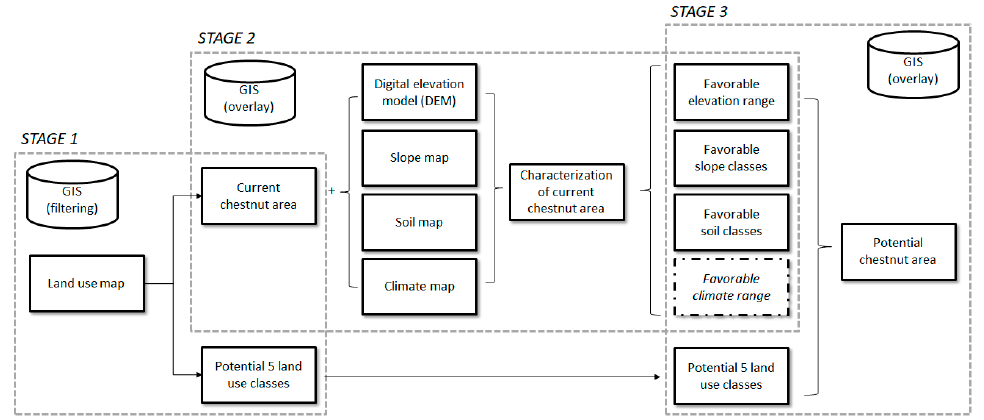
Figure 2. Flowchart of the GIS methodology. Stage 1: filtering of the land use map to obtain the current chestnut area and the potential land use classes; Stage 2: characterization of the current chestnut area through the extraction of favorable physiographic conditions; Stage 3: obtention of a potential chestnut area accordingly to the physiographic characteristics of the current area and available land use classes in the productive region.